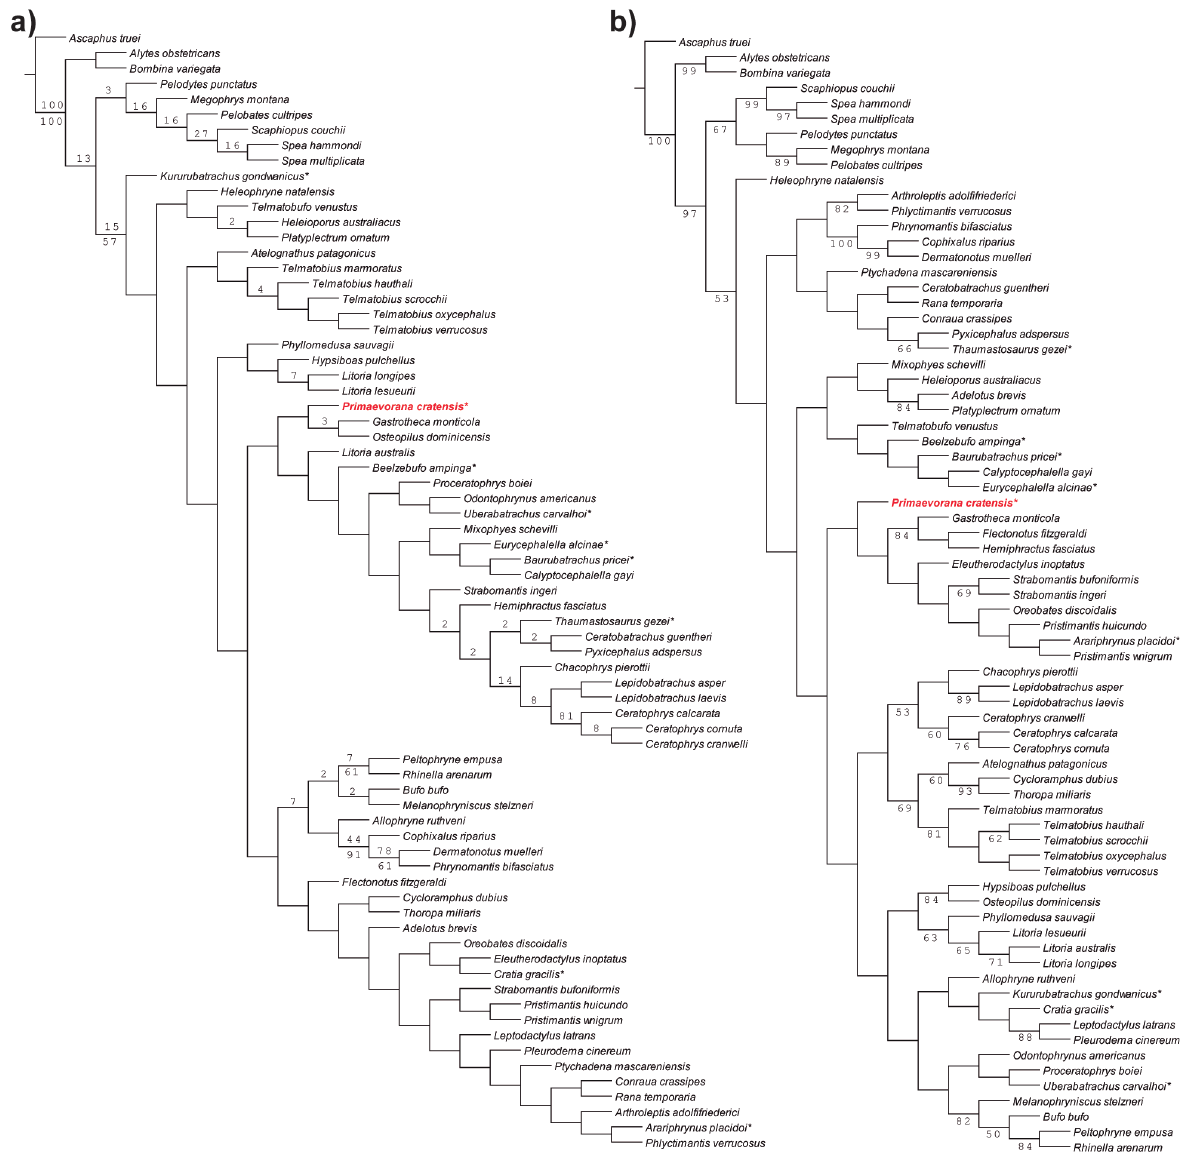
Figure 6. Phylogenetic trees obtained from the maximum parsimony analyses using the heuristic search of TNT v. 1.1, under implied weights. a) Unconstrained analysis with k = 7; b) Constrained analysis with k = 15. The fossil taxa are indicated with an asterisk. The new species is highlighted in bold. Numbers above nodes are relative Goodman-Bremer support values; numbers below nodes are Jackknife values. Only Jackknife values above 50% are